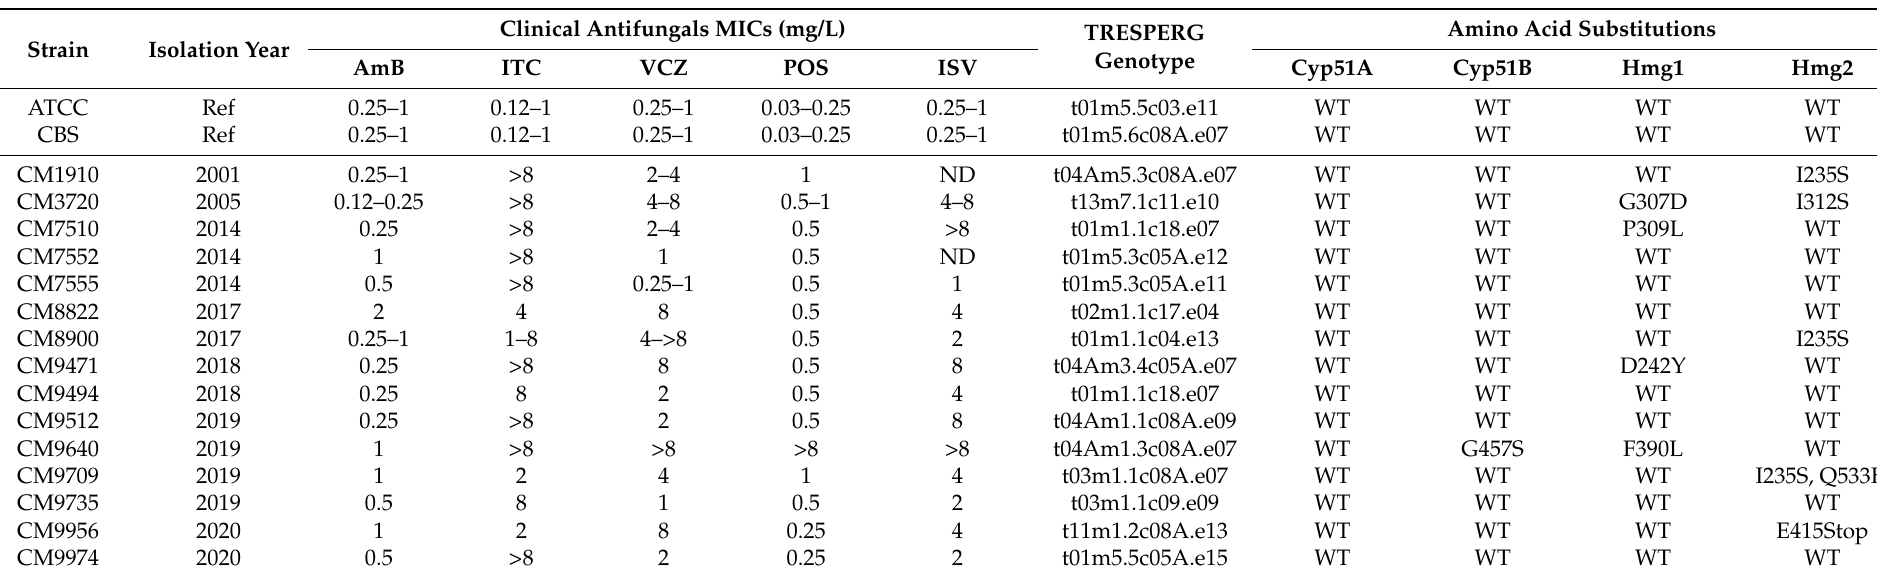
Table 2. Clinical A. fumigatus isolates resistant to clinical azoles including information about year of isolation, minimal inhibitory concentrations (MICs) to clinical antifungals, genotype and amino acid substitutions in genes related to azole